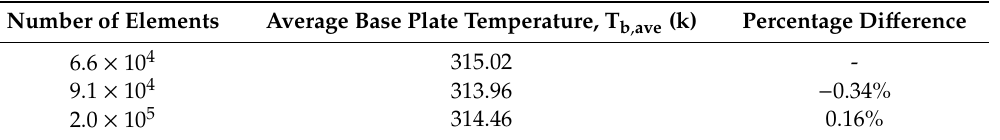
Table 3. Grid independence